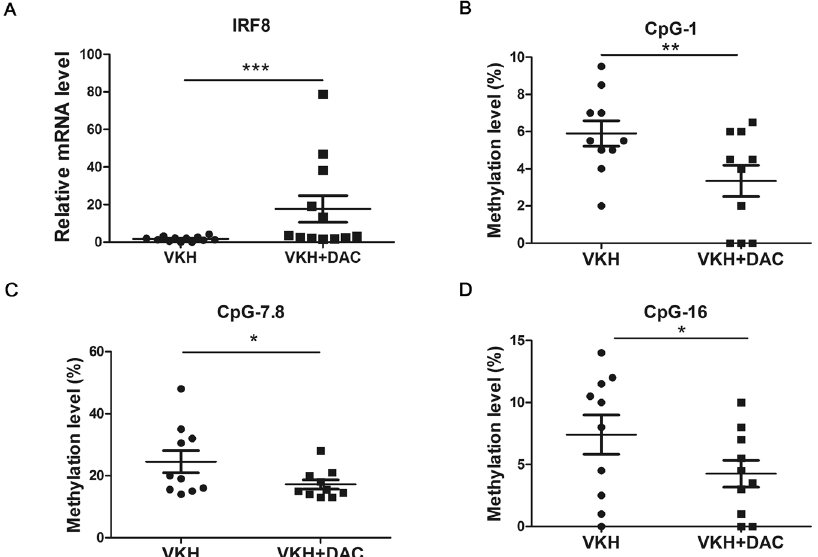
Figure 4. DAC treatment shows a demethylation effect and restores the mRNA expression of IRF8. ( A ) DAC treated and untreated DCs from active VKH patients were collected to detect the expression of IRF8 with real- time PCR (VKH, n = 12, VKH + DAC, n = 12, *** p < 0.001). The methylation changes in CpG_1 ( B ), CpG_7.8 ( C ) and CpG_16 ( D ) of DAC treated and untreated DCs from VKH patients were evaluated with MALDI- TOF mass spectrometer (VKH, n = 10; VKH + DAC, n = 10, * p < 0.05, ** p < 0.01). The data are shown as mean ± SEM. Paired-t test was used to compare the methylation changes between two